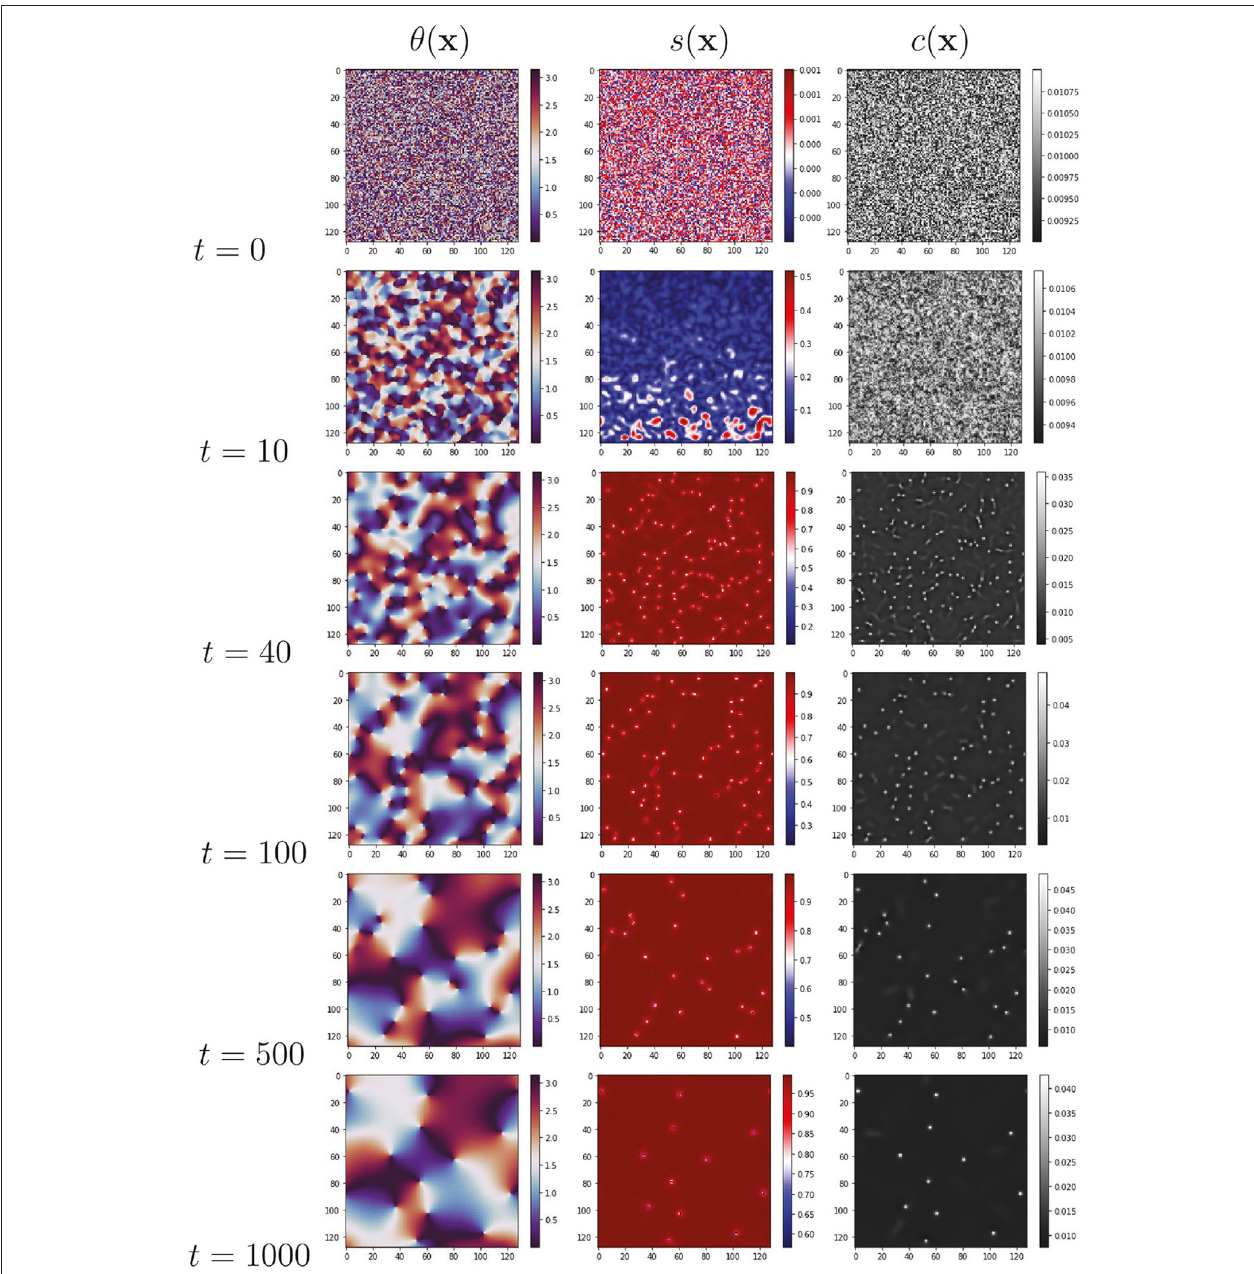
FIGURE 2 | Time evolution of director orientation θ ( x ), nematization s ( x ) and NP concentration c ( x ) from the tensor dynamical Equations (14), for NP mobility parameter R 0.1. As for the scalar dynamical equations, NP material aggregates at the low nematization regions, which correspond here to point disclinations. As = the disclinations annihilate, NP material is released back into the nematic domains where it diffuses away. Parameters g through the run, so that the equilibrium values of s